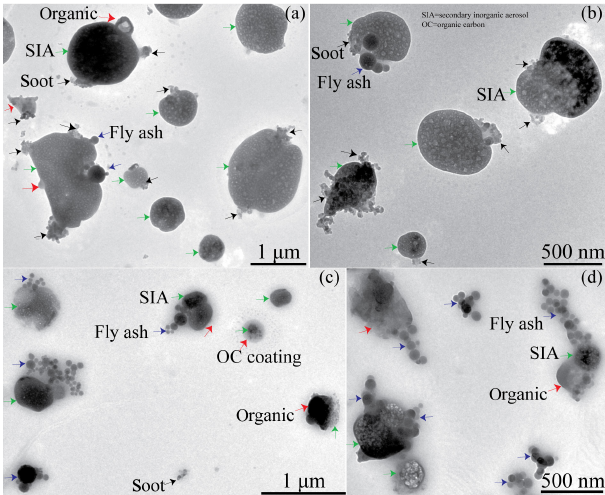
Figure 10. Individual particles collected under PM 2 . 5 mass concen- tration among 10–30µgm − 3 . (a) Mixture of SIA and soot, fly ash particles collected on 14 September. (b) Mixture of SIA and soot, fly ash particles collected on 18 September. (c) Mixture of SIA and fly ash, soot, organics collected on 29 September. (d) Mixture of SIA and fly ash, soot, organics collected on 10 October. Organics are heterogeneously mixed with